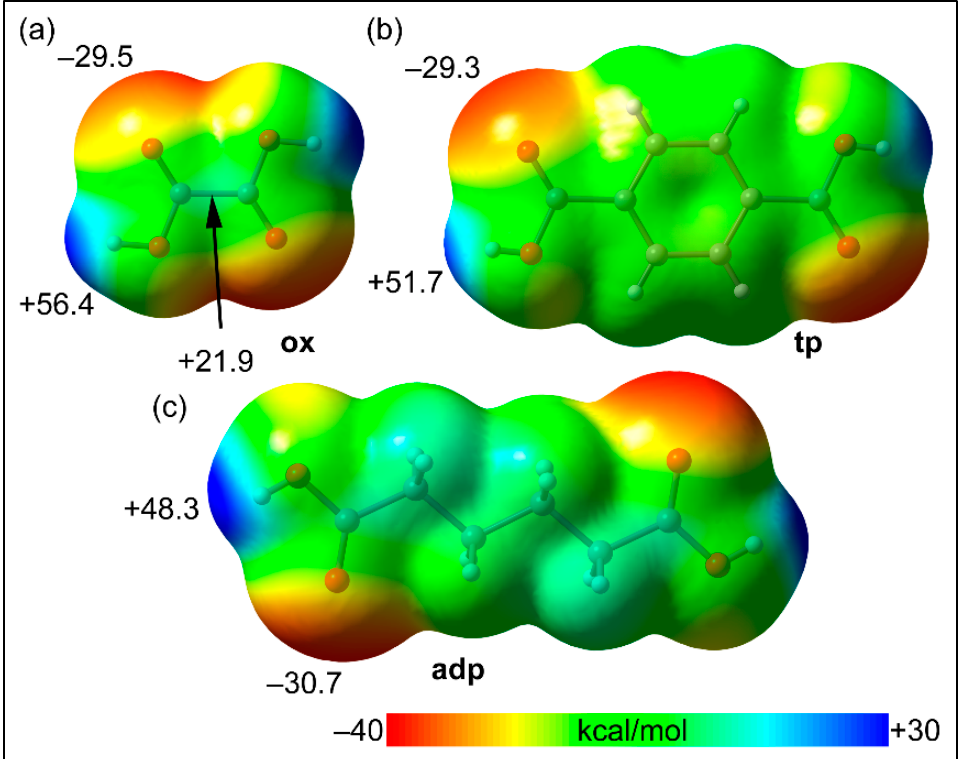
Figure 7. MEP surfaces of dicarboxylic acids; ox ( a ), tp ( b ) and adp ( c ) at the PB86-D3/def2-TZVP level of theory. The energies at selected points are given in kcal/mol. Isosurface 0.001 a.u.